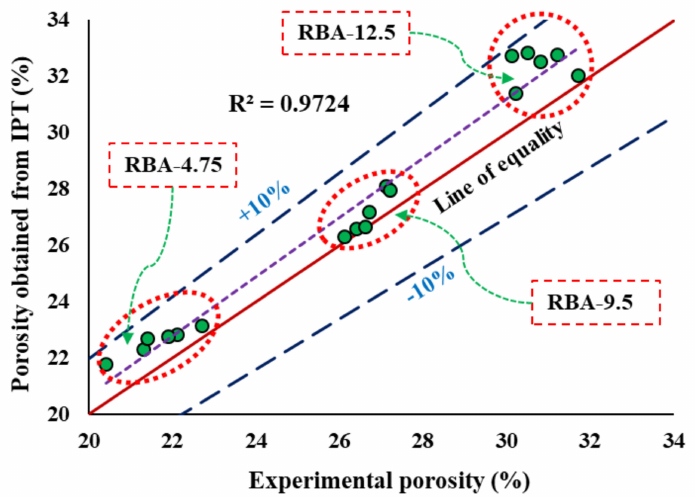
Figure 7. Typical RAEs for mixes with different aggregate sizes.